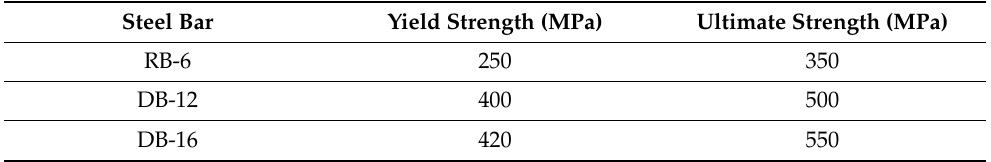
Table 2. Measured mechanical properties of steel